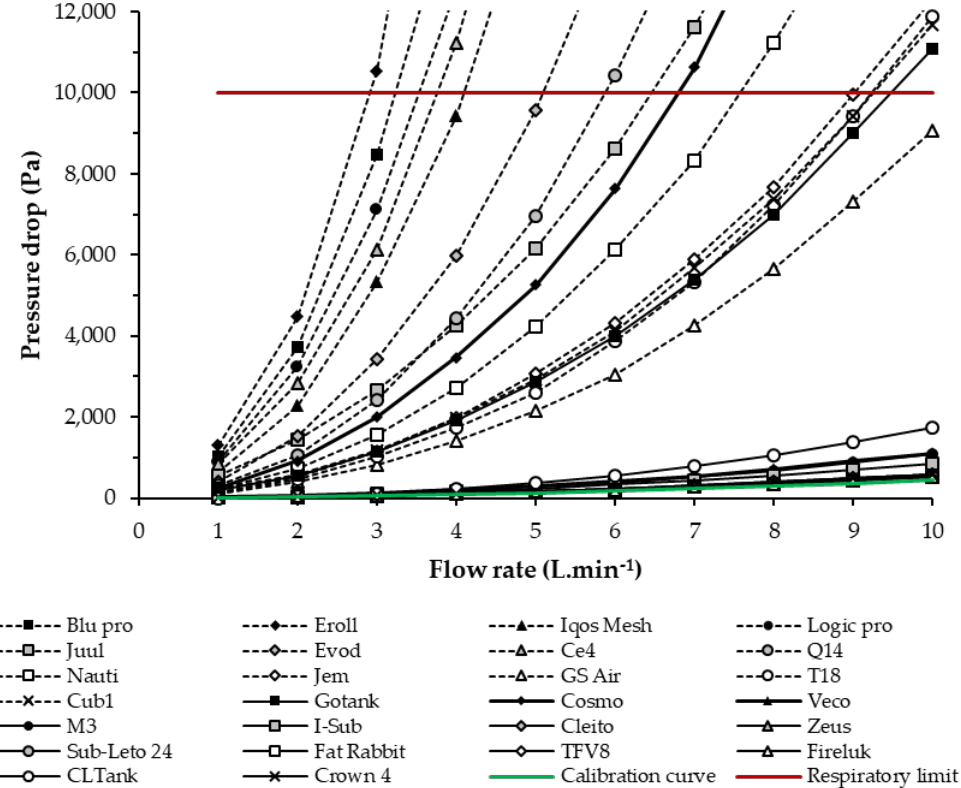
Figure 12. Pressure drop curves of the twenty-six tested devices according to the airflow rate. Graphically, each device has a parabolic profile due to the pressure drop square root (Equation (3)), then verified with the R-square (0.9904–0.9996) when air resistances are extracted. Two groups are clearly identifiable. The first one reaches the respiratory limit for airflow rate between 2 and 11 L min − 1 and curves are dispersed. The second group have low-pressure drops and do not exceed 2000 Pa at 10 L min − 1 with a small variability. Their curves look to be overlapped and are hardly separately observable. Finally, the air resistances are determined. They are subtracted by the empty setup air resistance (obtained by the calibration). Figure 13 illustrated the treated air resistance.